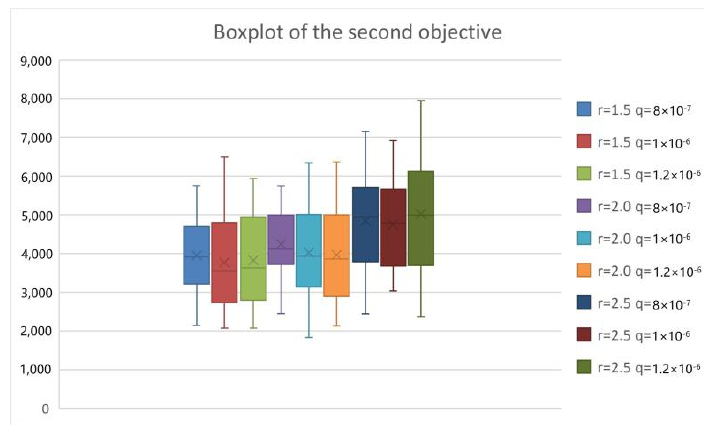
Figure 10. Boxplot chart of the total transfer time.